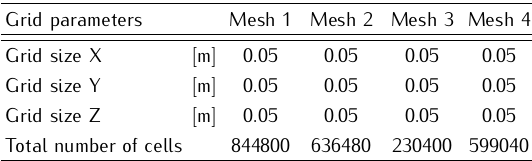
Table 8. Grid independent solution – meshes